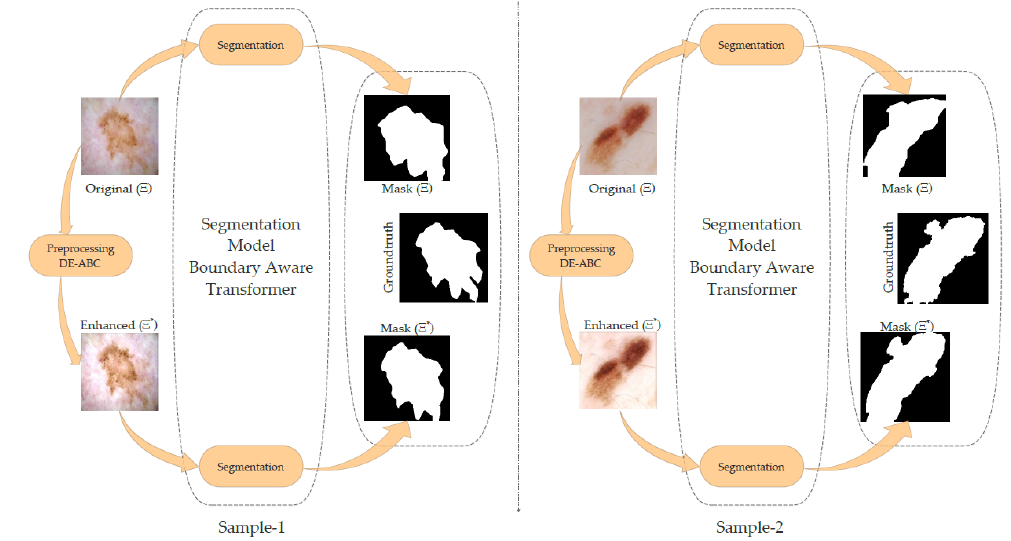
Figure 6. DE-ABC effects on boundary-aware transformer